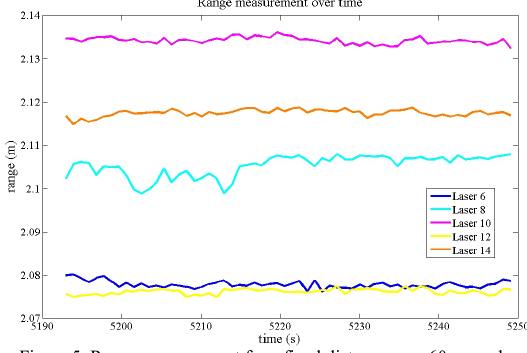
Figure 5. Range measurement for a fixed distance over 60 seconds (Lasers: 6, 8, 10, 12 and 14)